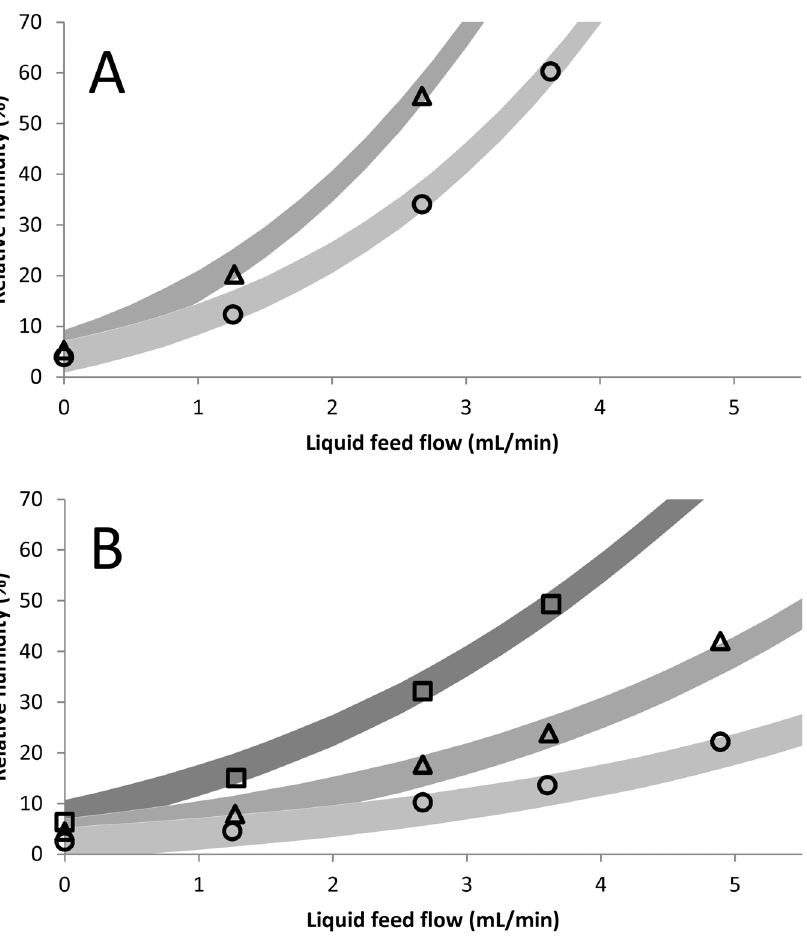
Figure 5. Modeled (grey) and experimental (black) relative humidity. Measurements were done at an inlet temperature of 90 u C (circle), 70 u C (triangle), or 50 u C (square). Results shown at the top (A) were obtained with an aspirator flow of 12 m 3 n /hr and the results on the bottom (B) with 22 m 3 n /hr. Thickness of the lines indicate the 95% confidence interval of the modeled relative humidity (3.1% RH).